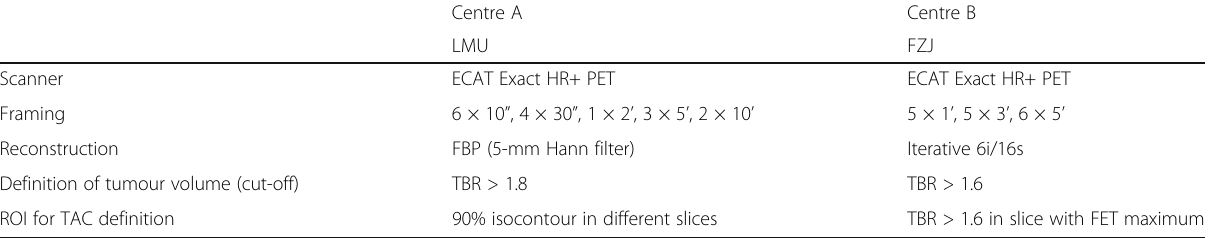
Table 1 Comparison of methodology centre A and centre